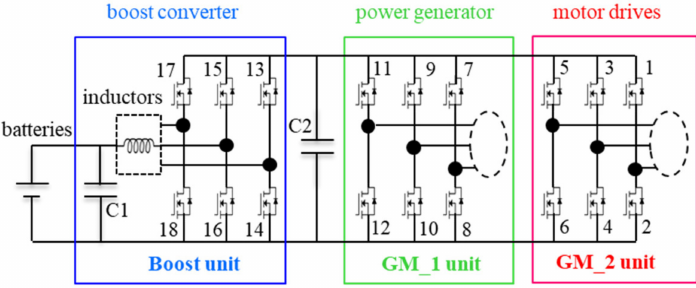
Figure 2. Circuit topology of the developed PCU module. The 1st phase is the rightmost phase, the 2nd phase is the middle phase and the 3rd phase is the leftmost phase in each power converter unit. For example, the 1st phase of the GM_2 unit consists of I1 and I2 IGBT dies and d1 and d2 FRD dies, the 2nd phase of the GM_1 unit consists of I9 and I10 IGBT dies and d9 and d10 FRD dies, and the 3rd phase